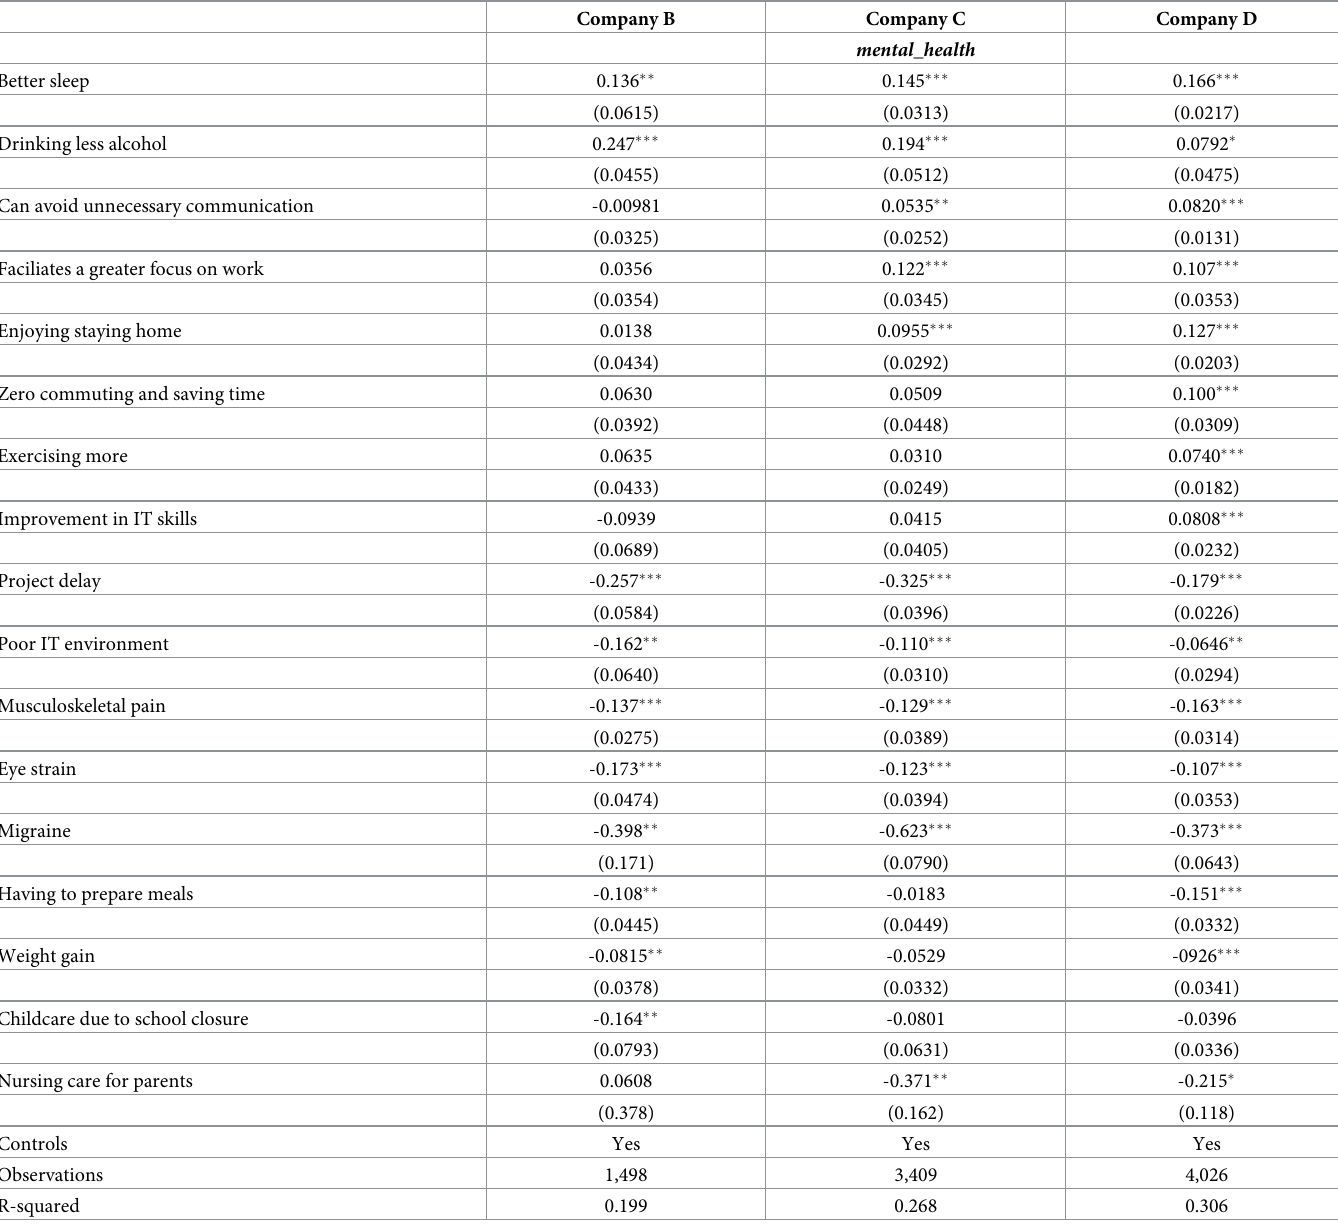
Table 10. Regression of mental health on the perceived advantages and disadvantages of